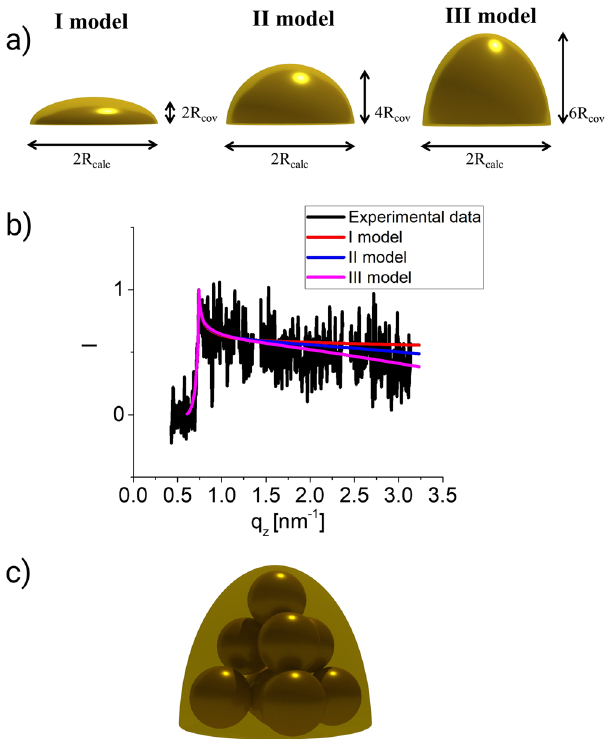
Figure 4. ( a ) Sketch of the hemispheroidal models as used in the IsGISAXS simulations. R cov = covalent radius of Au. R calc is the calculated radius for Au 9 clusters. ( b ) GISAXS off-detector (along q z ) line cuts for the simulated shapes and experimental data at the position with the maximum amount of material obtained from the XRF data. Pink curve - Au 9 spot, black curve - hemispheroids with the height of 1 Au atom, red curve- hemispheroids with the height of 2 Au atoms, blue - hemispheroids with the height of 3 Au atoms. ( c ) Possible structure of the soft-landed Au 9 on the Si surface according to the experimental data.